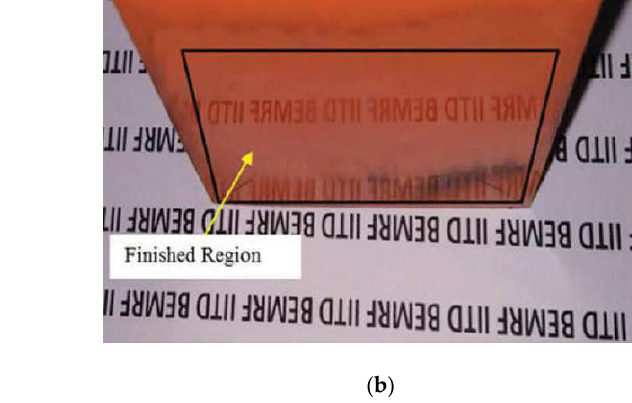
Figure 8. FDM-ed sample: ( a ) unfinished surface and ( b ) finished surface after applying the BEMRF process [19].